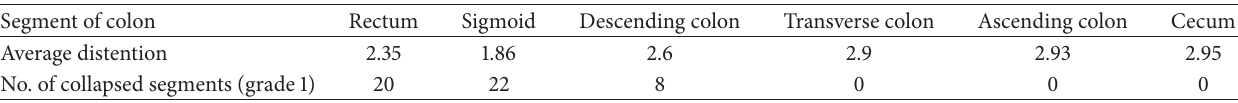
Table 1: The average distention score for each of the 6 colonic segments examined. The total number of collapsed (grade 1) segments found is also